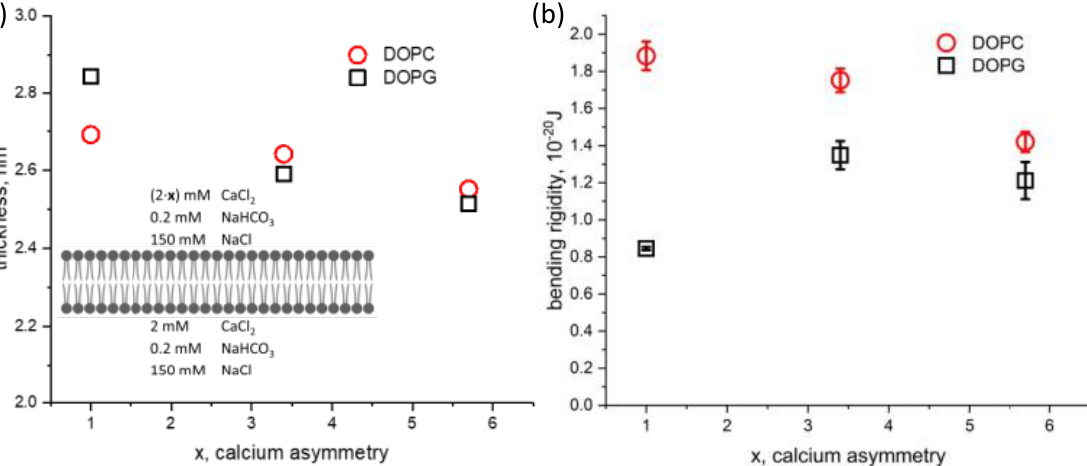
Figure 4. Dependence of ( a ) hydrophobic membrane thickness and ( b ) membrane bending rigidity on the degree of calcium asymmetry factor, x , in the aqueous phase surrounding symmetric DOPC and DOPG bilayers. The factor x represents the degree of calcium asymmetry across the membrane, ranging from 2 mM/2 mM ( x = 1, symmetric) to 10.4 mM/2 mM ( x = 5.7, asymmetric), as shown in the inset schematic.